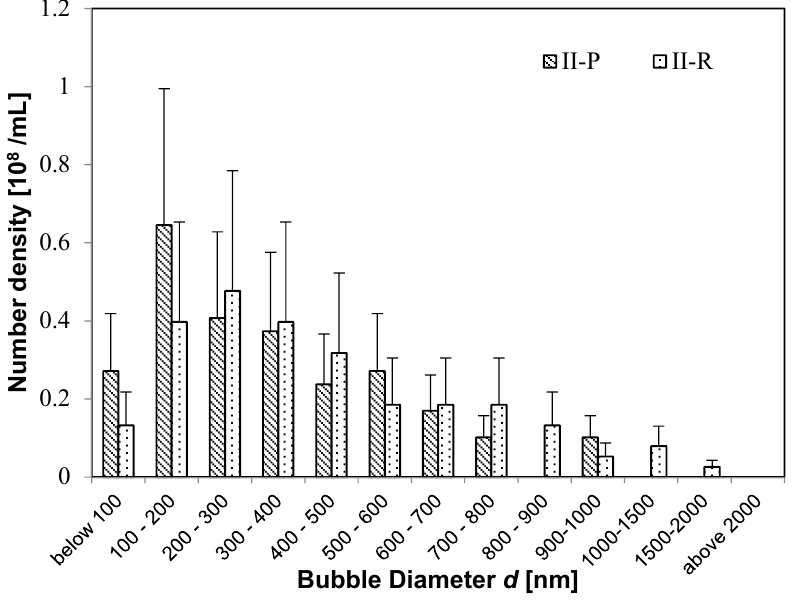
Figure 5. Same as Figure 4 except for the control case. Before supply to plants: II-P (thin oblique line). After reaching roots: II-R (thin points).